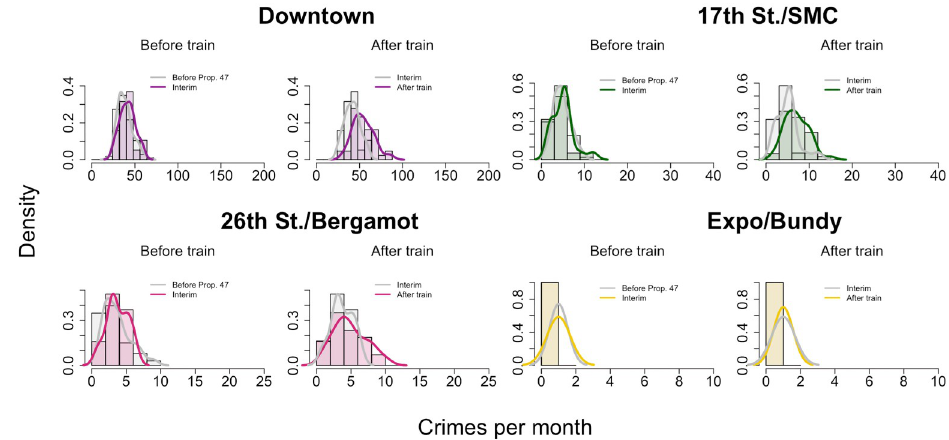
Fig 13. Reported Prop. 47 crime near Expo Line light rail stations in Santa Monica, CA, during three successive time periods spanning 2006–2019. This figure is analogous to Fig 12, but restricted to Prop. 47 crimes only. See Table 5 for statistical test results.